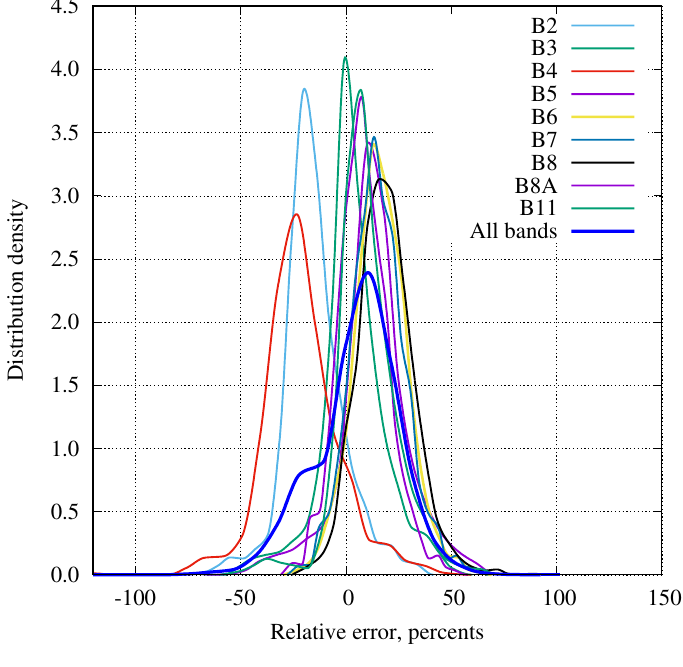
Figure 12. Relative errors of simulated spectra, broadleaf